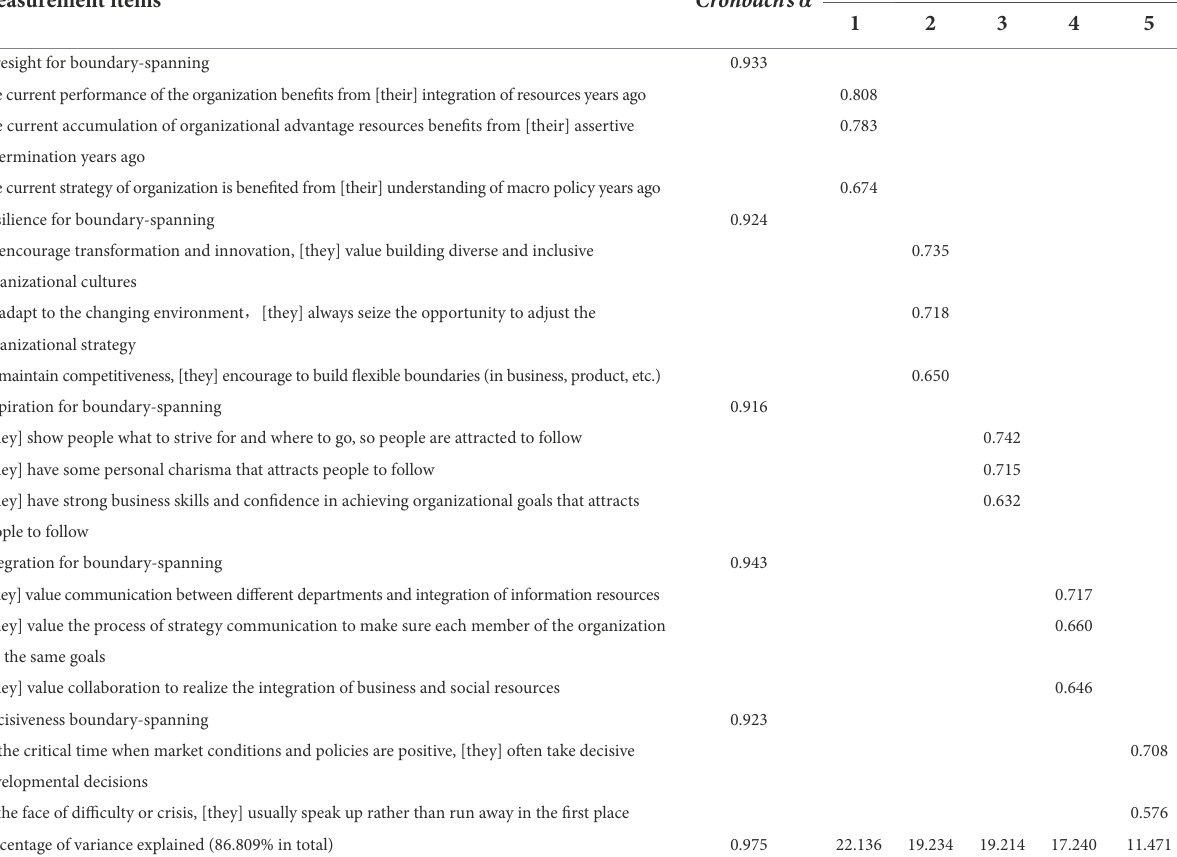
TABLE 2 Exploratory factor analysis for